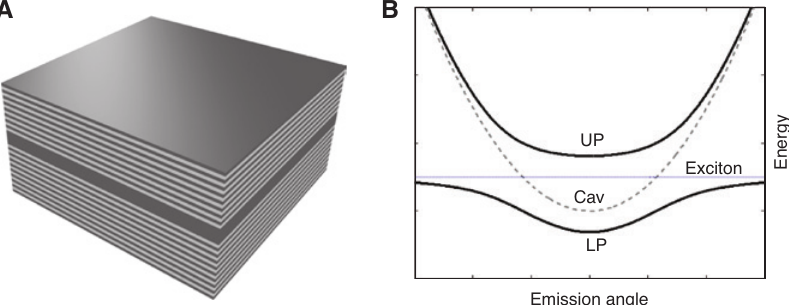
Figure 1: Strong exciton-photon coupling in a semiconductor microcavity. (A) A microcavity sample: an active material (exciton) is embedded between two high-reflective mirrors. (B) A typical polariton dispersion [upper (UP) and lower (LP) branches] arising from the strong coupling between excitons and a cavity mode